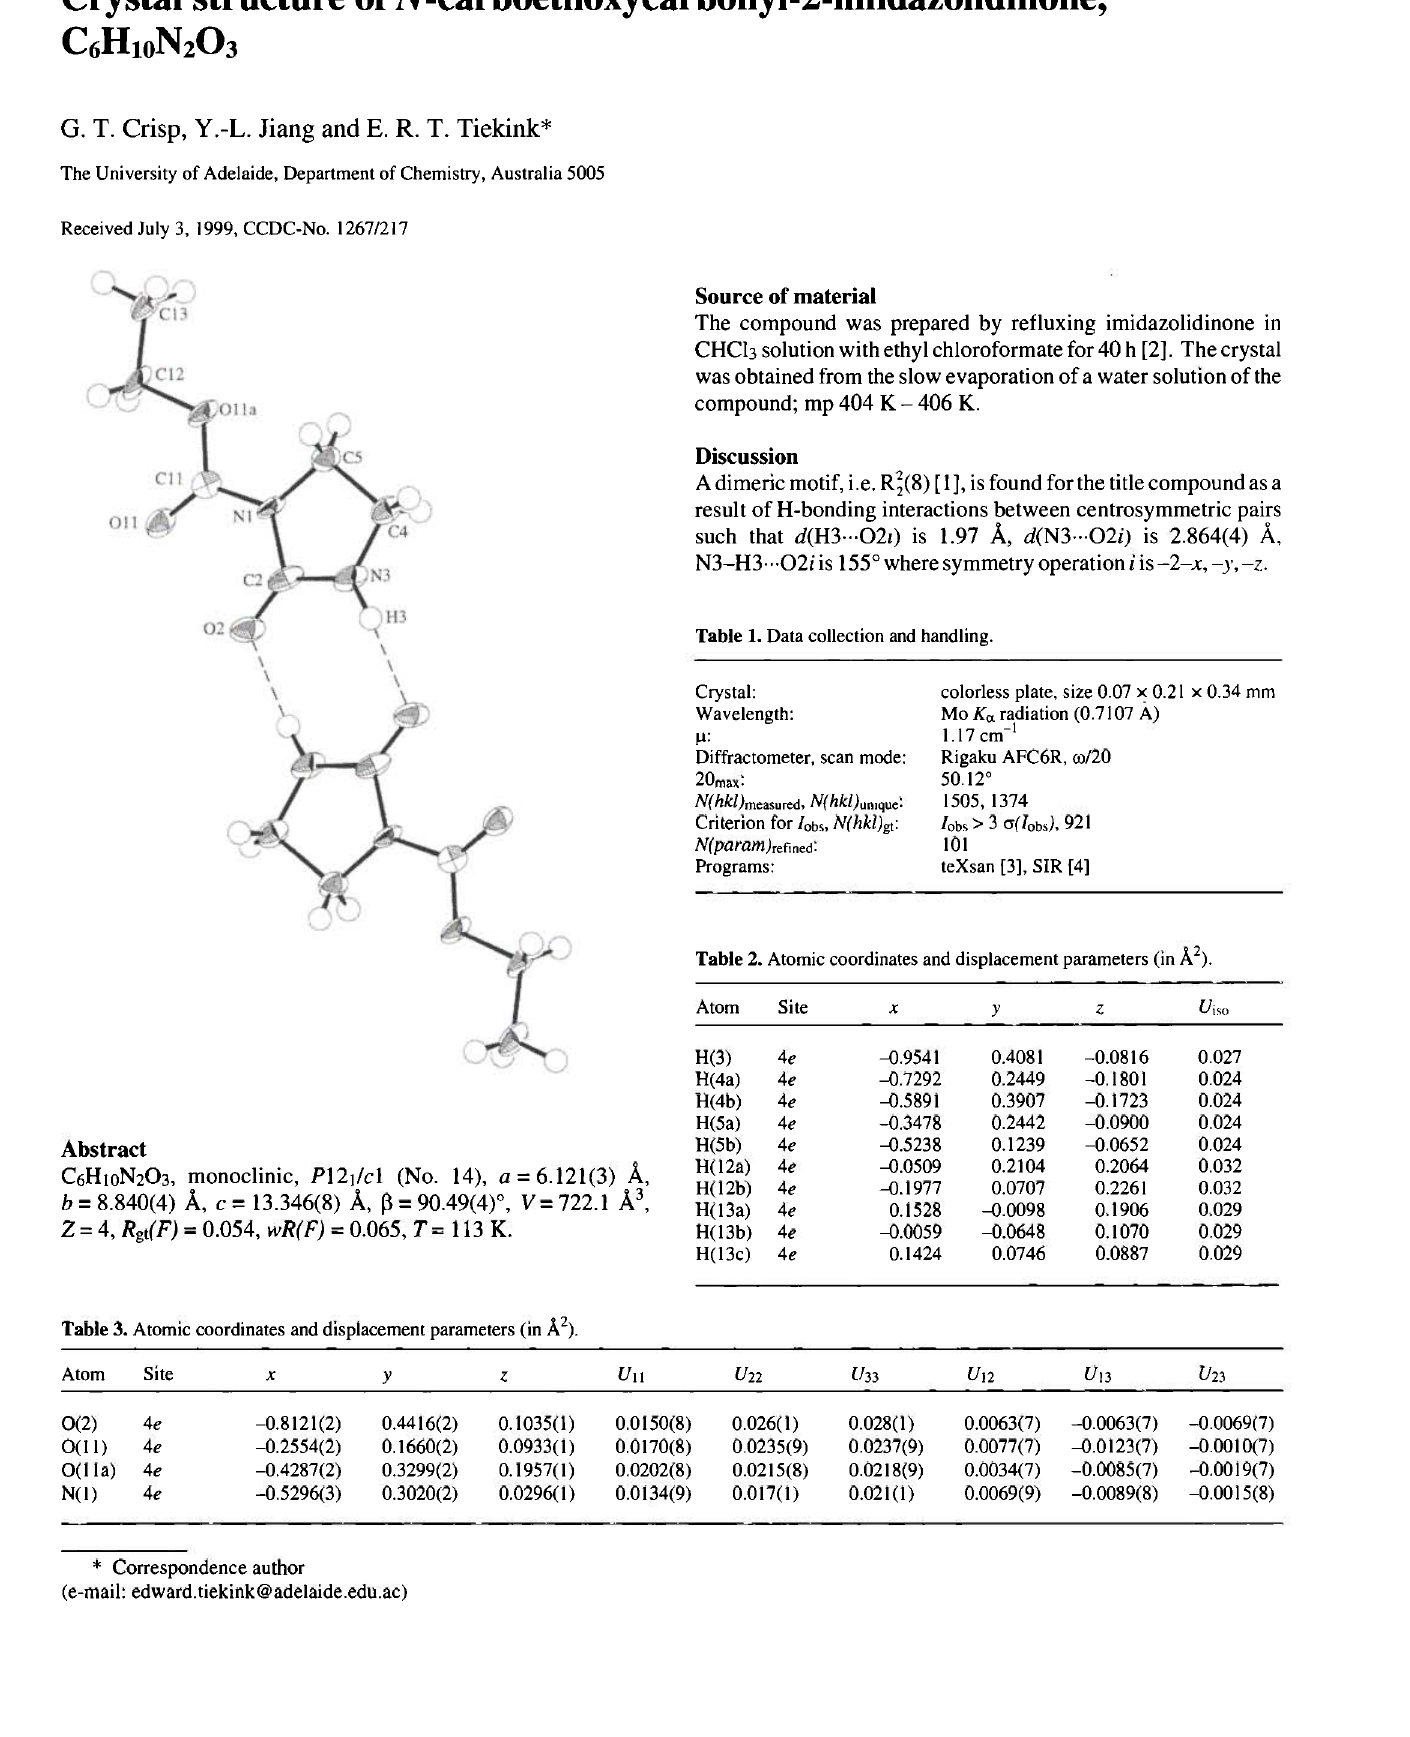
Table 1. Data collection and handling. Crystal: